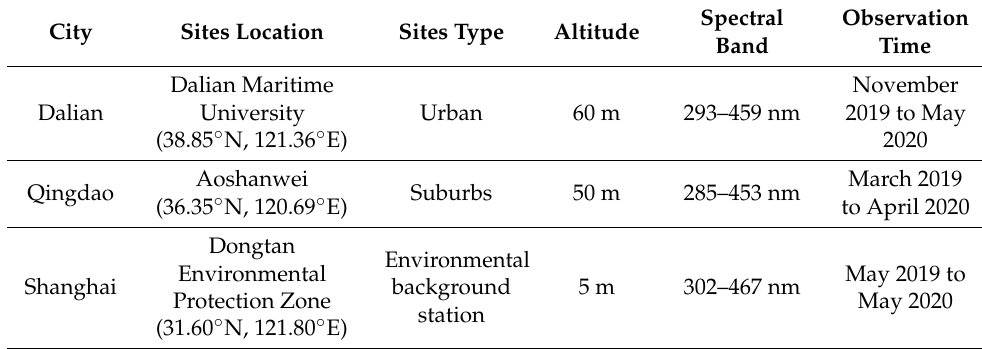
Table 1. The site differences between Dalian, Qingdao, and Shanghai.